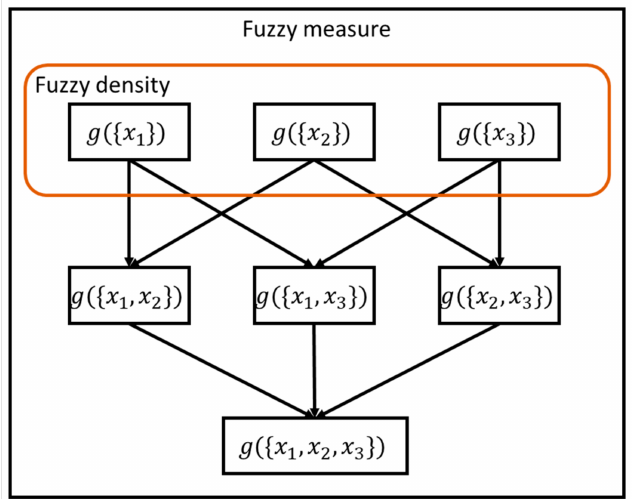
Figure 6. Relationship between fuzzy measures and fuzzy density.